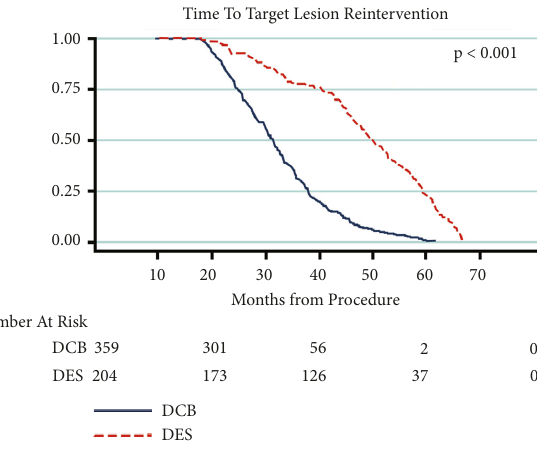
Figure 6: Time to TLR. In patients who required clinically driven target lesion reintervention, DES had a significantly longer time to TLR. Average of additional 373 days to TLR in the DES cohort compared to DCB. DCB � drug-coated balloons; DES � drug- eluting stents.